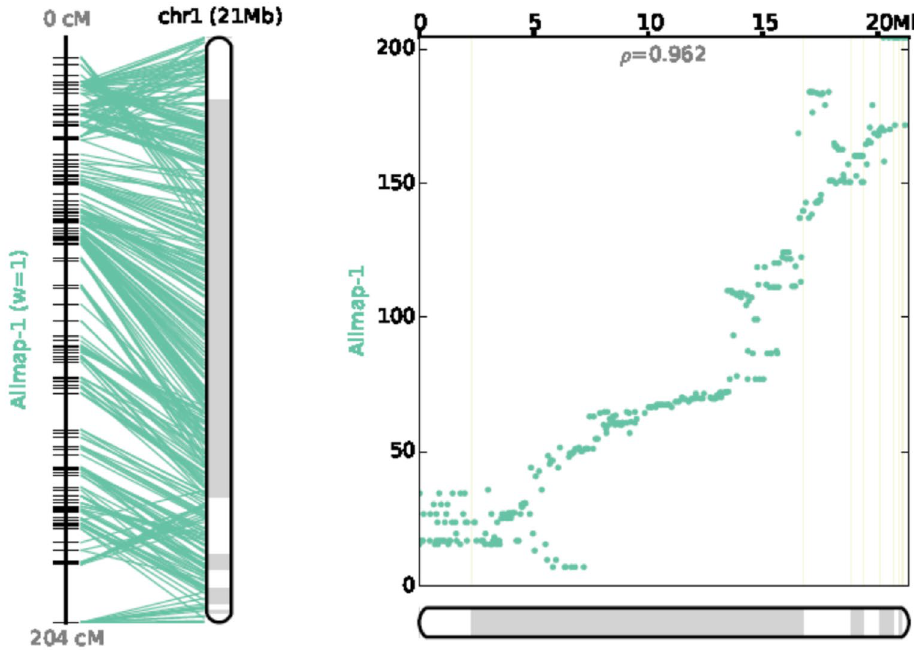
Figure 2. Chromosome 1 co-linearity between the SLAF-based high-density genetic map and the corresponding chromosome assembly by ALLMAP (https:// github. com/ tangh aibao/ jcvi/ wiki/ ALLMA PS) 49